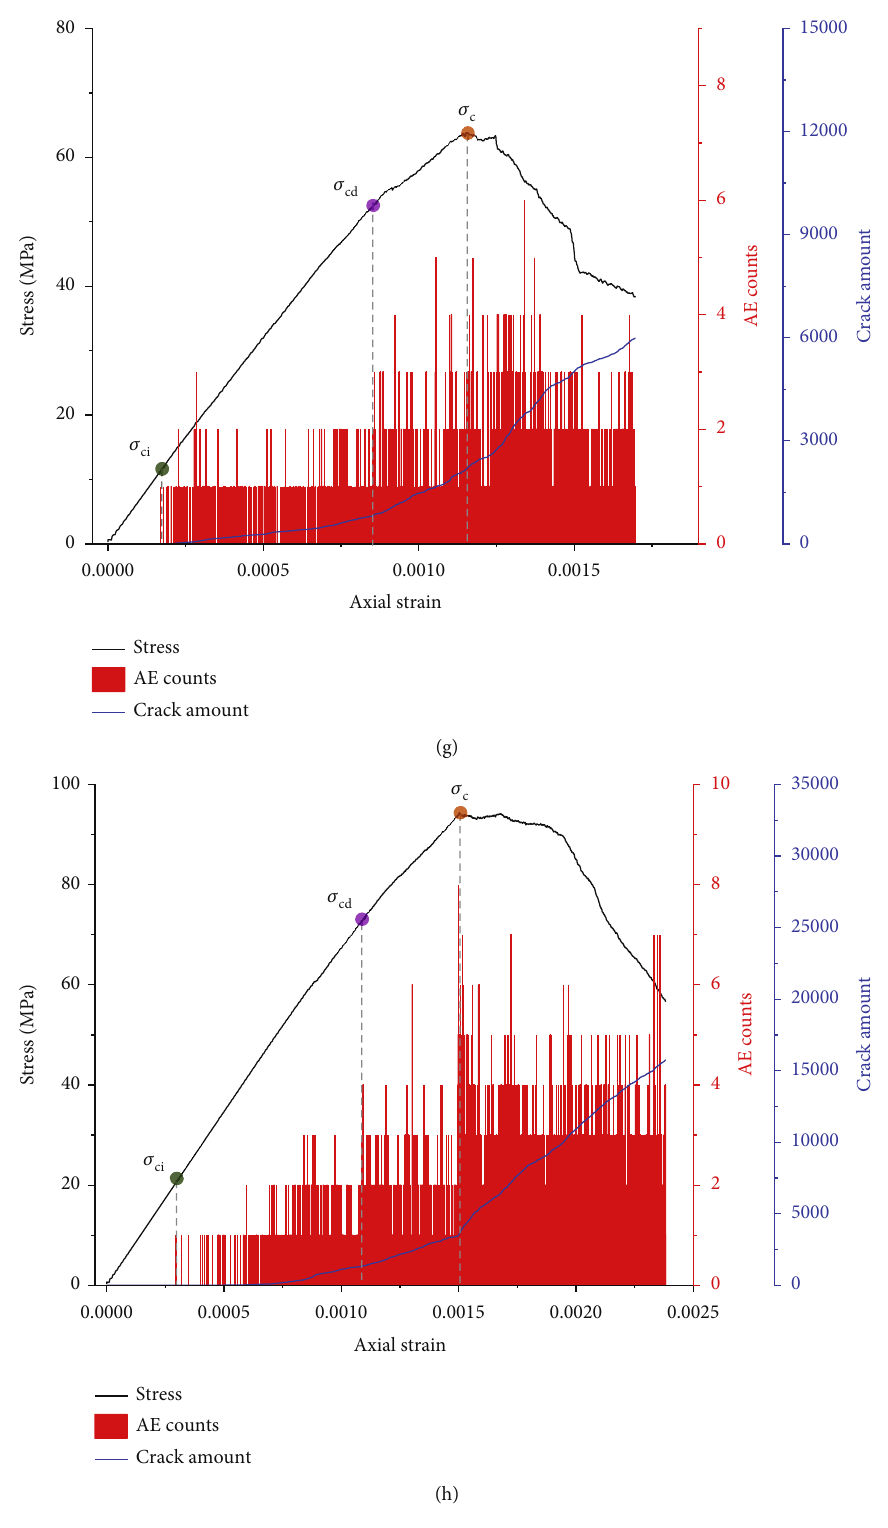
Figure 4: Stress-strain-acoustic emission-crack number curves of each model: (a) represents the intact model; (b – h) represent the NM-1 model to the NM-7 model,